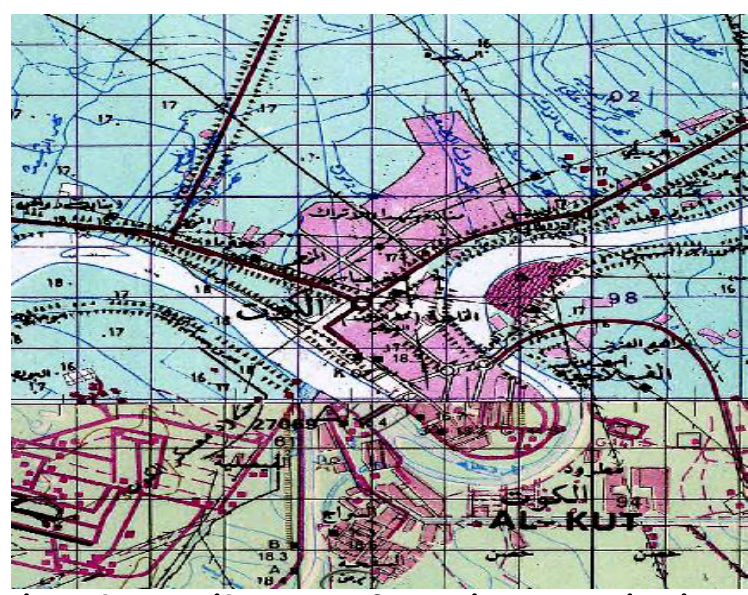
Fig. 3: The map with 1:100,000 for Kut city, Wast province in